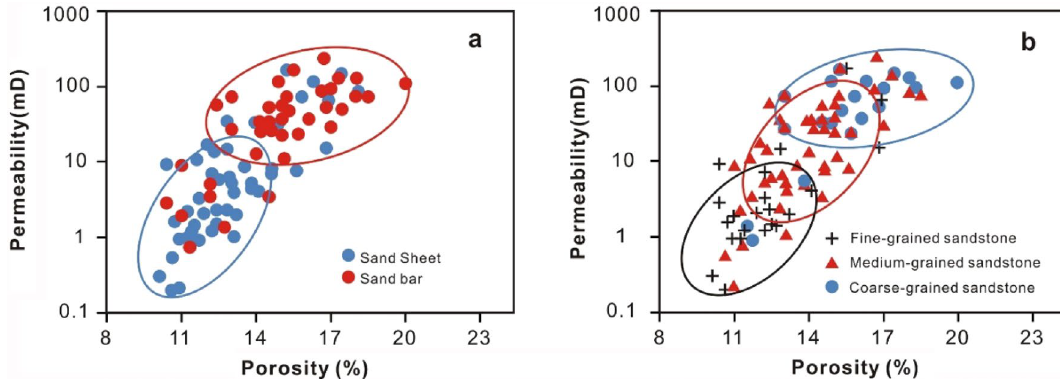
Figure 10. Statistics of porosity and permeability of different depositional elements ( a ) and different grain- sized sandstones ( b ).